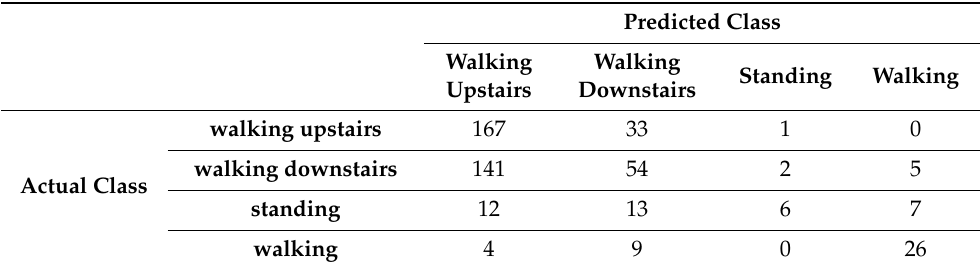
Table 7. Confusion matrix for normalized accelerometer data with Z-Score.